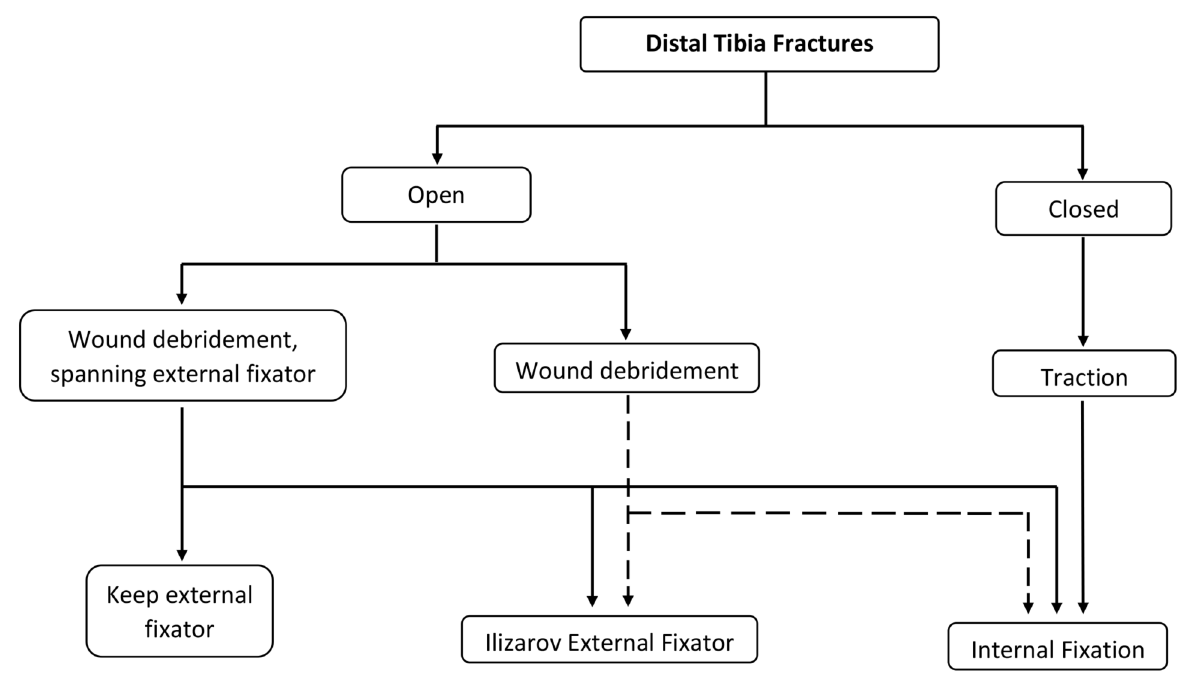
Proposed algorithm for management of distal end tibia Fig. 1: